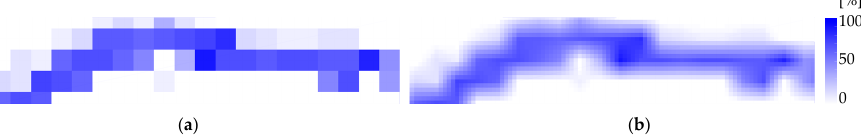
Figure 8. An example of bilinear interpolation of water fractions; ( a ) water fractions at the pixel level, and ( b ) interpolated water fractions at the sub-pixel level with ZF = 5.